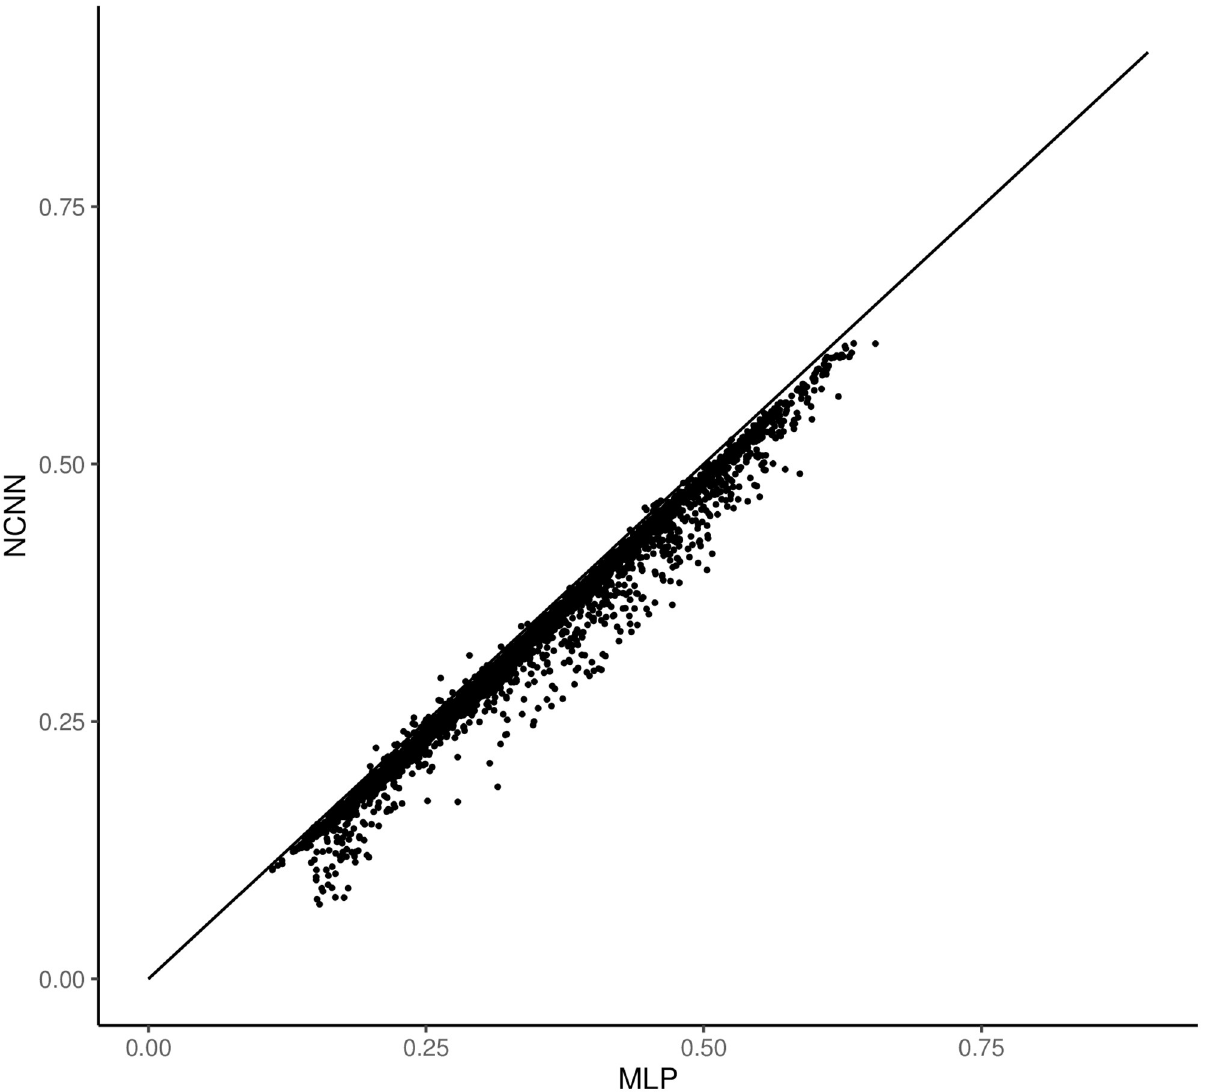
Fig 4. The comparison of mean average error of predictions on each gene in GEO dataset. The y value is the mean average error from NCNN model on each target gene; the x value is the mean average error from MLP model on each target gene. Each dot below the diagonal means that NCNN has lower prediction error on this gene than the comparing